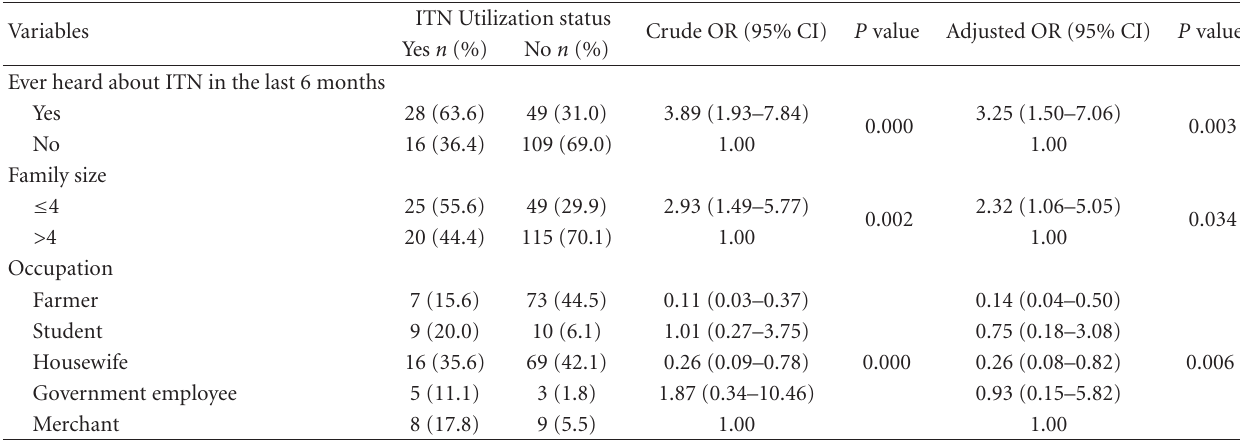
Table 5: Final logistic regression model for household’s ITNs use (with estimated odds ratios) in Gursum district, Ethiopia, 2008.